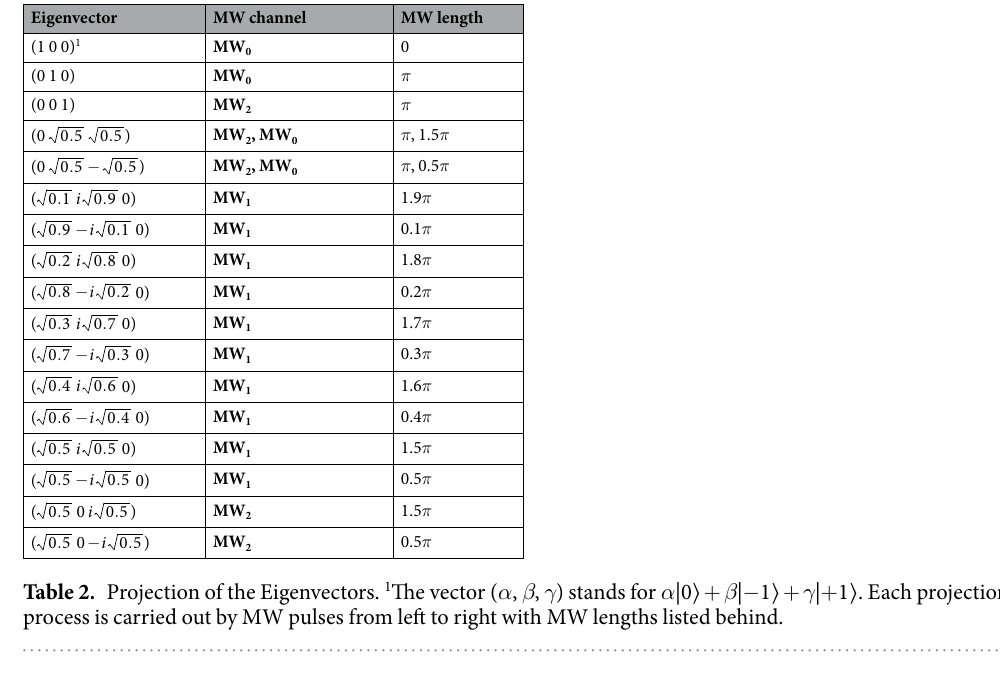
the entropic uncertainty relations predicted by the theory and the lower bounds. The difference between the theoretic prediction and experiment result may be attributed to decoherence of electron spin during the controls also manifested by the lower bounds of entropic uncertainty relations discussed in the Methods.